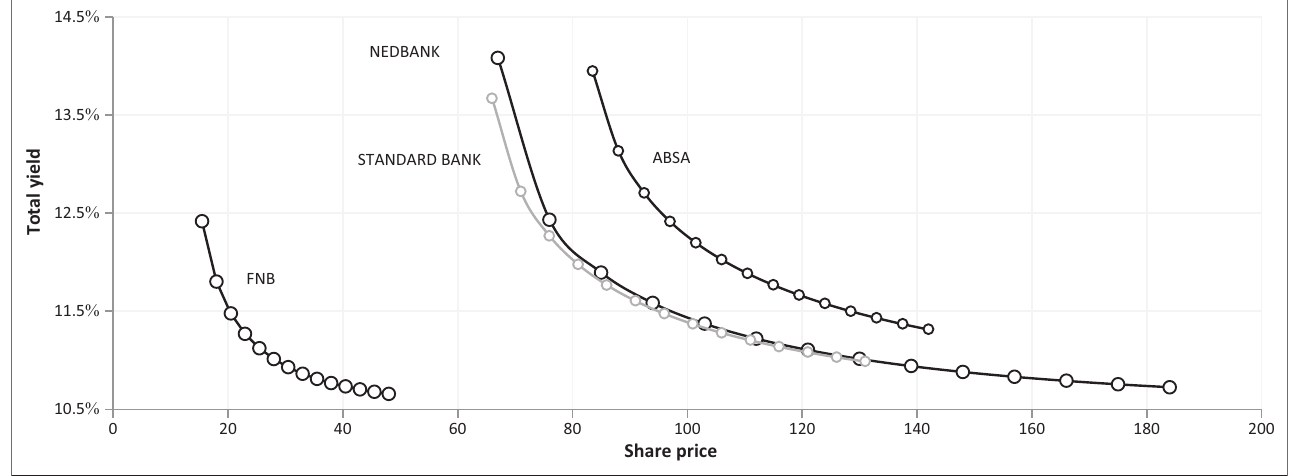
FIGURE 10: Contingent convertible yields for various South African bank share